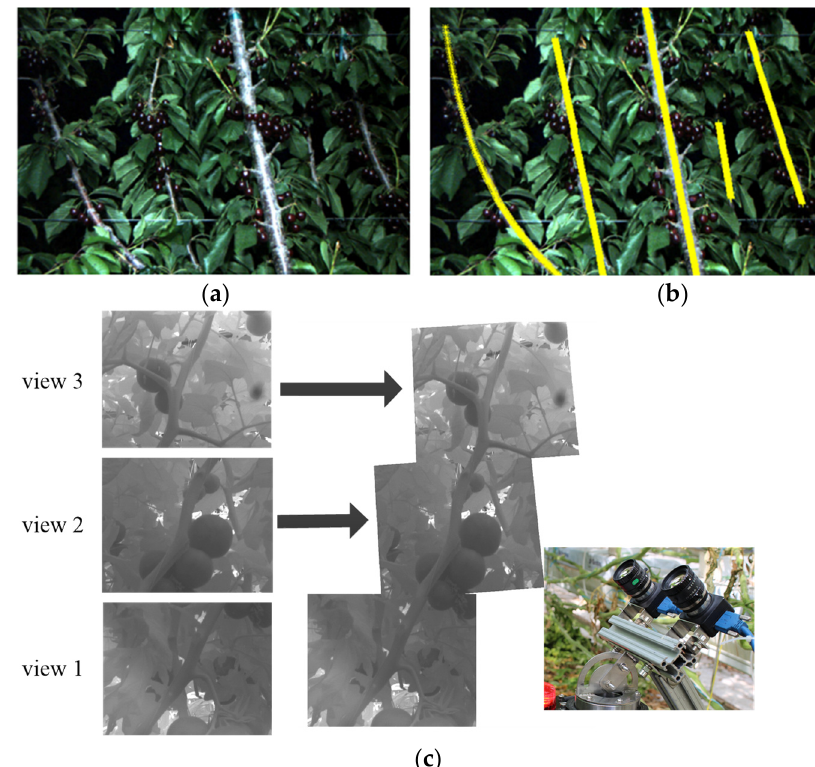
Figure 12. The multi-view active search guided by the growth form of plant stem. ( a , b ) Detection of cherry tree branches for automated sweet-cherry harvesting (Photo: Reprinted with permission from Ref. [105]. 2020, Li J.); ( c ) tomato plant main-stem tracking and measuring based on binocular pan-tilt vision unit (Photo: Reprinted with permission from Ref. [106]. 2020, Feng Q.).